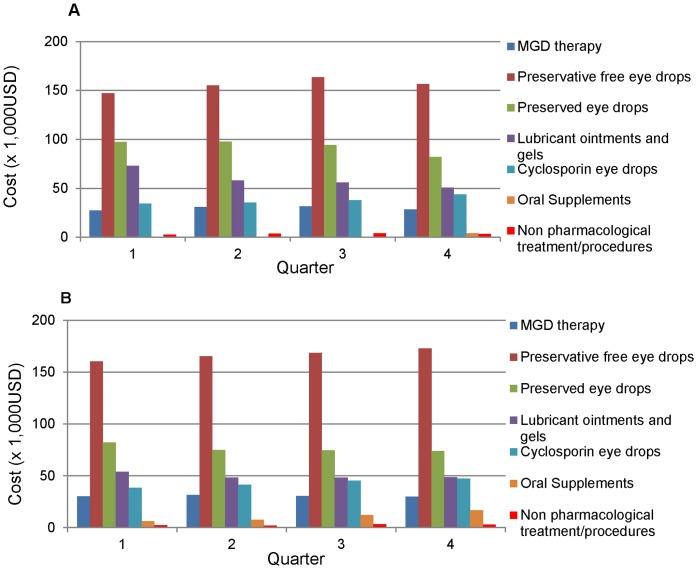
Distribution of quarterly expenditure among different treatment groups in 2008 & 2009.

Figure 2A:
 Quarterly expenditure in 2008 
Figure 2B:
 Quarterly expenditure in 2009.